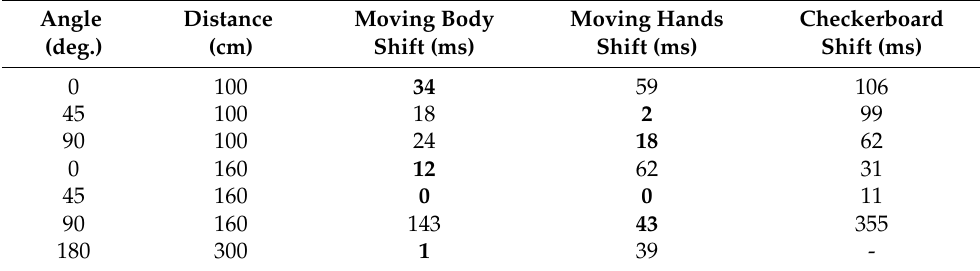
Table 1. Human motion-based synchronization results compared to Microsoft’s cable-based synchro- nization method. Angle Distance Moving Body Moving Hands Checkerboard